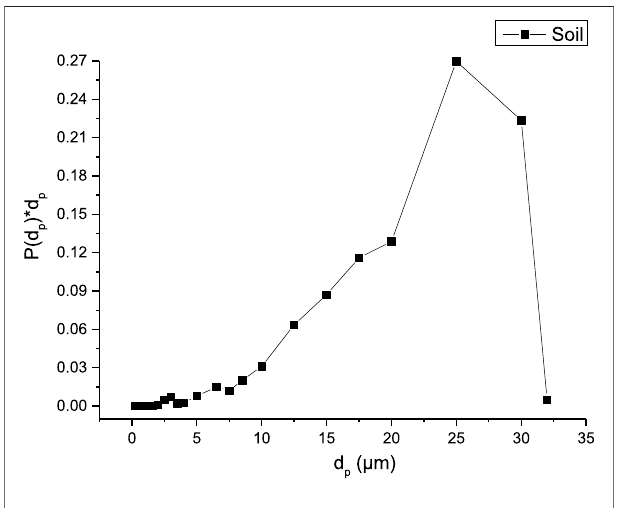
FIGURE 9 | The reduction ratios of particle concentration at the bottom of bogies G and L ( RNB i and RNL i ) over the incoming particle concentration.